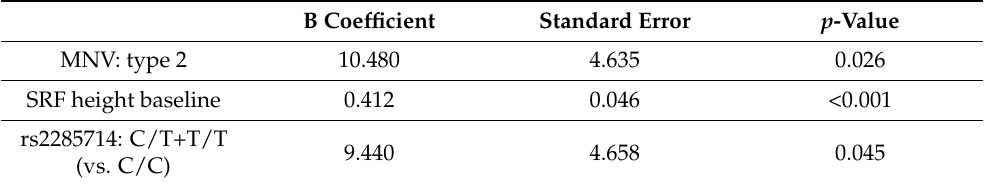
Table 10. Final step of stepwise linear regression showing significant predictors of SRF height after